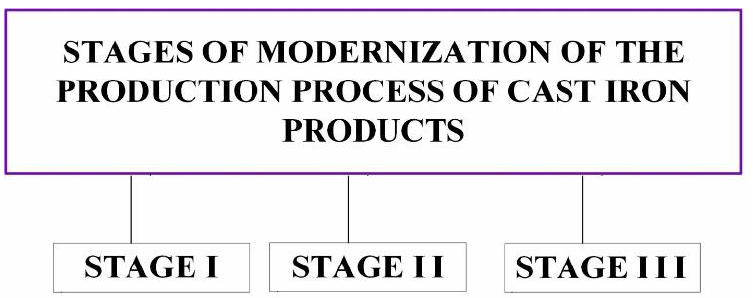
Figure 6. Schedule of modernization of the casting process.